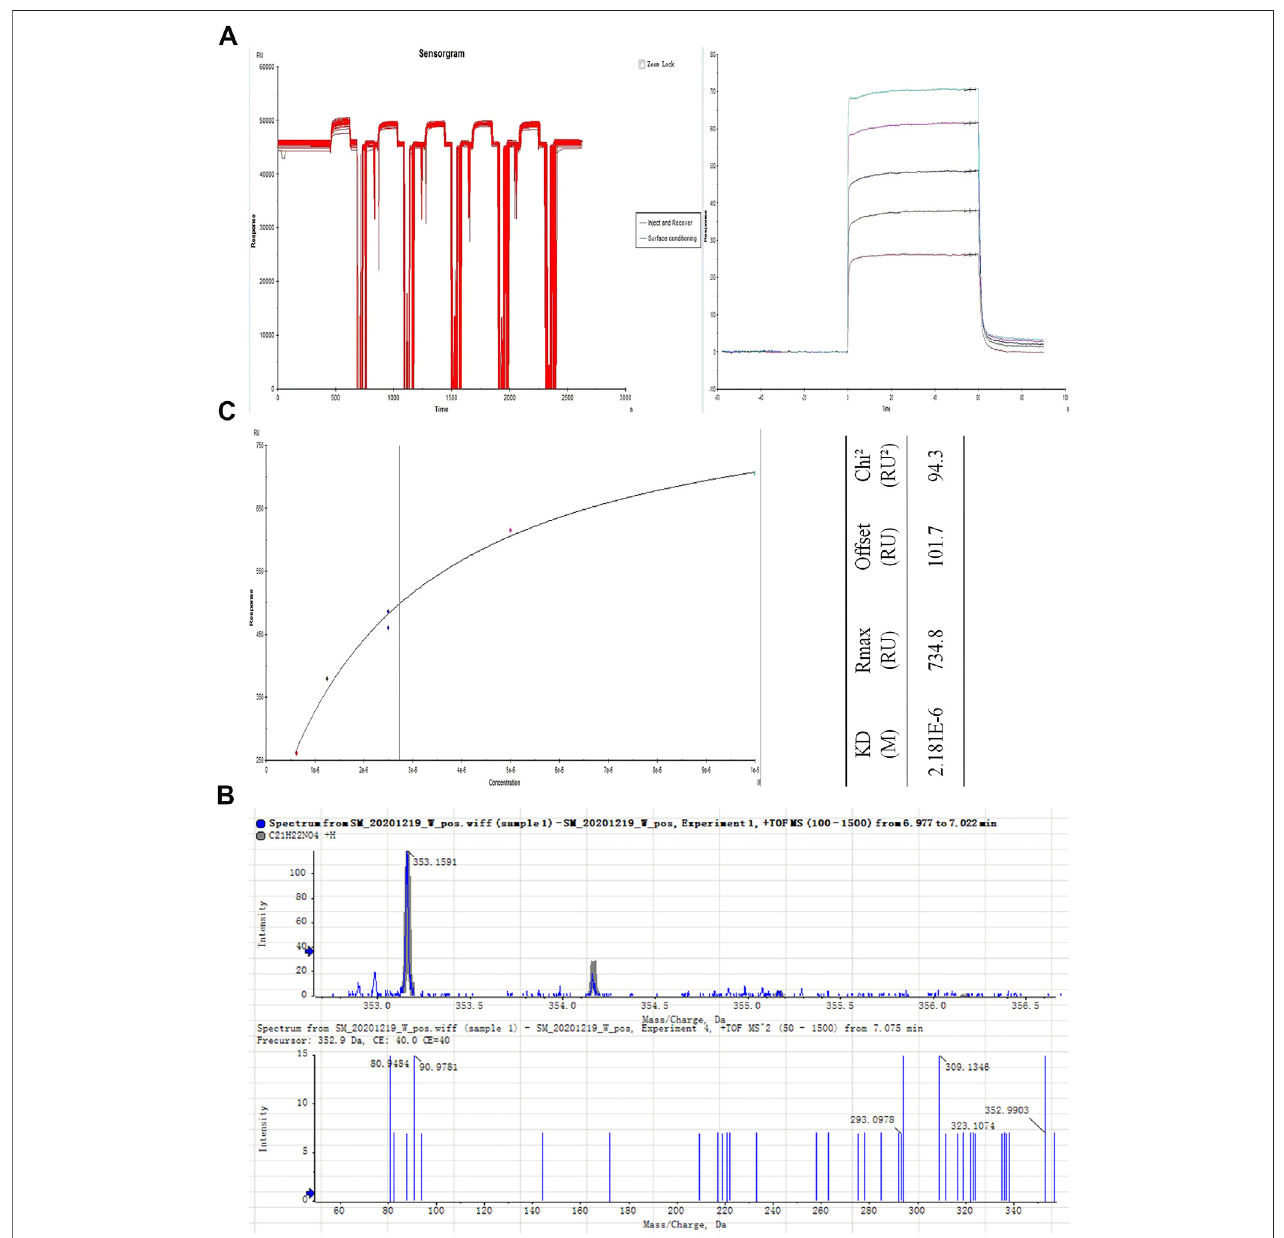
FIGURE 2 | Isolation and identi fi cation of the JinQi Jiangtang tablet (JQJTT)-derived fi broblast growth factor receptor 1 (FGFR1) activator palmatine (PAL). (A) The variation in response values for PAL/FGFR1 during the fi shing experiment. (B) Identi fi cation of PAL by mass spectrometry. (C) PAL/FGFR1 af fi nity characterization.